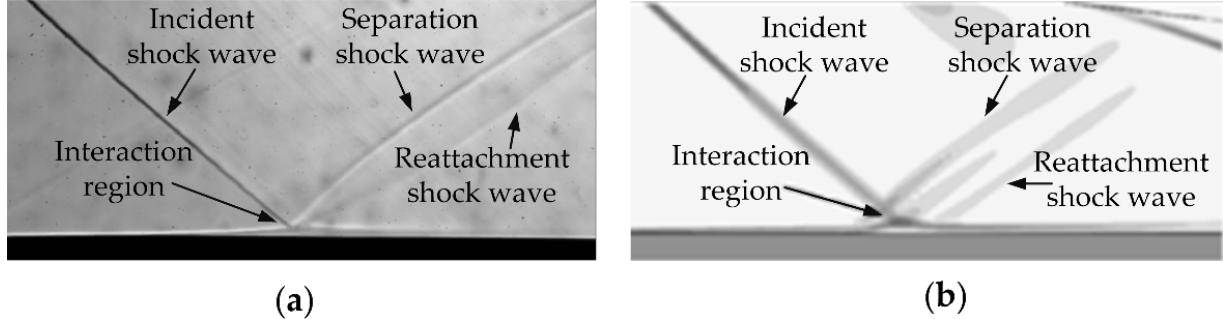
Figure 8. Comparison of experimental schlieren and DES simulation calculation: ( a ) experimental schlieren; ( b ) numerical schlieren.